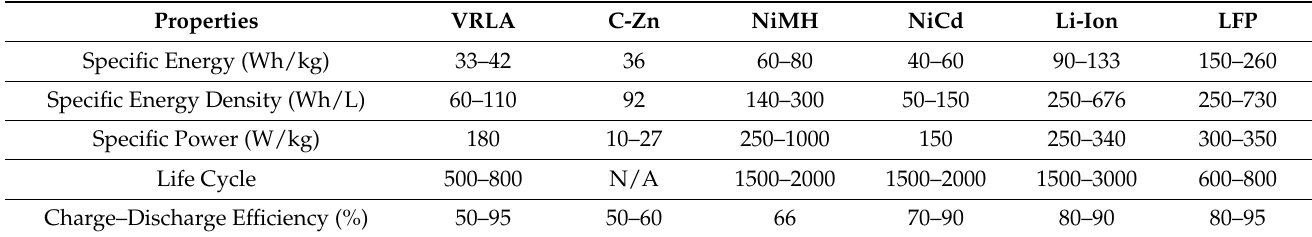
Table 1. Cell chemistry comparison [3,5,6].